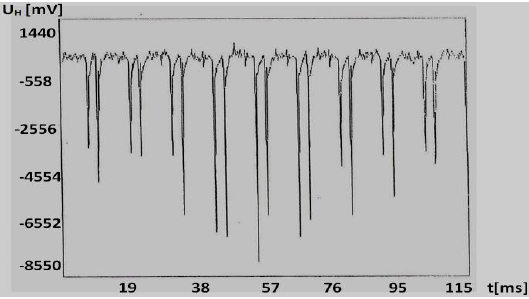
Figure 14. Hall voltage versus time in the case of the shorting of two commutator sectors, Hall sensors fixed on the stator, loaded starter. Appl. Sci. 2018 , 8 , x FOR PEER REVIEW